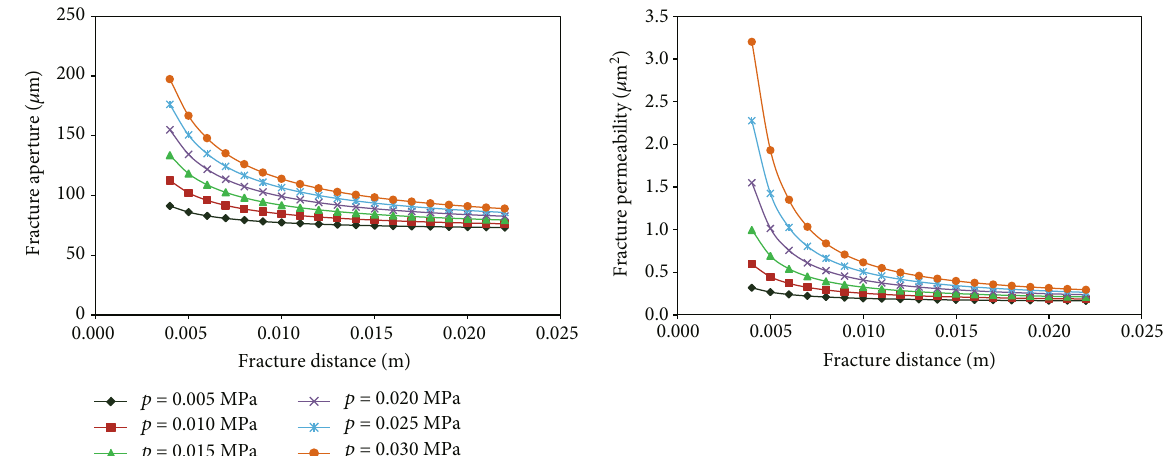
Figure 14: Fracture aperture and fracture permeability vs. initial fracture